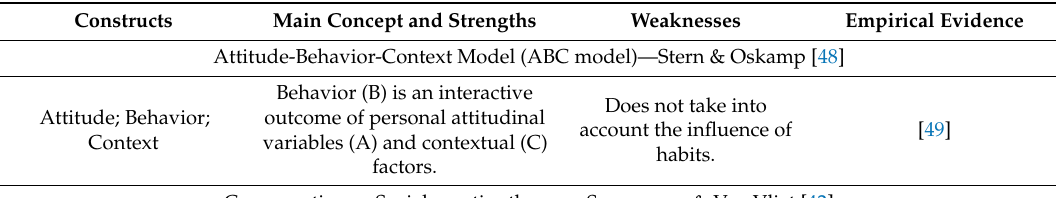
Table 2. Strengths and weaknesses of behavior change